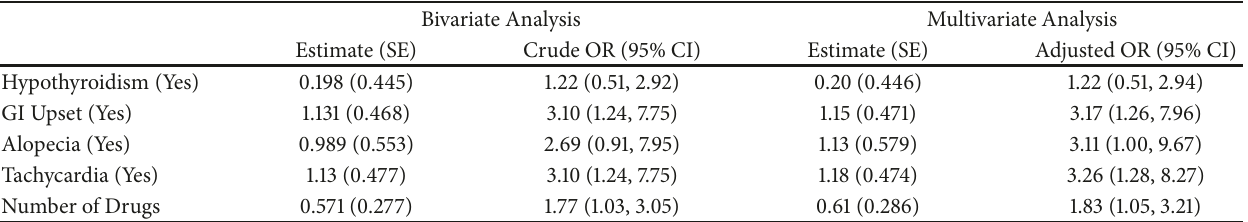
Table 4: Bivariate and multivariable logistic model analyses for assessing the risk factors associated with the development of gout among MDR-TB